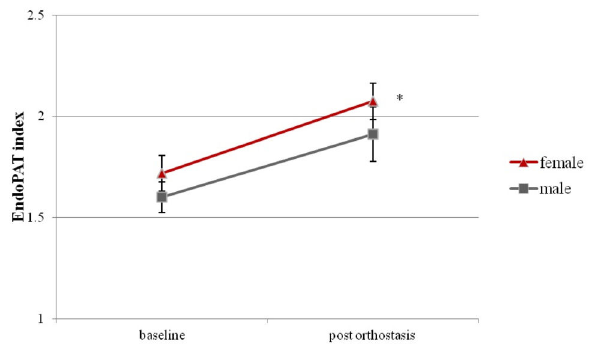
males at baseline and following 20 min of orthostatic challenge. * Indicates significance for change in EndoPAT index from baseline